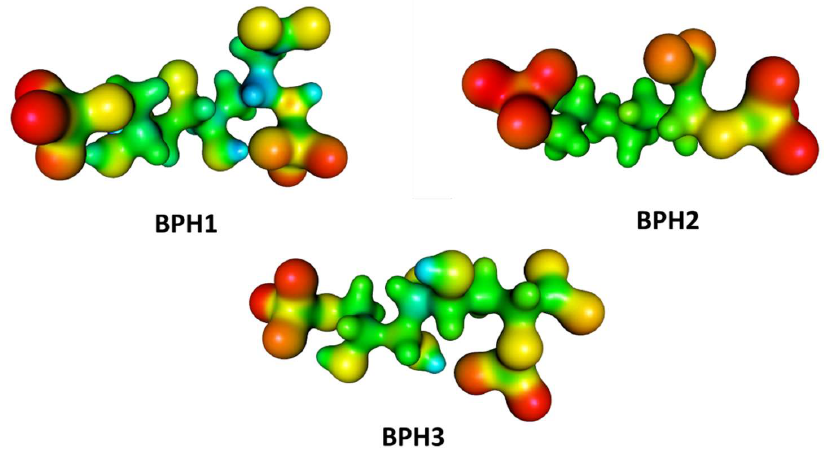
Figure 8. Molecular electrostatic potential (MEP) surfaces of biphosphate inhibitors BPH1, BPH2, and